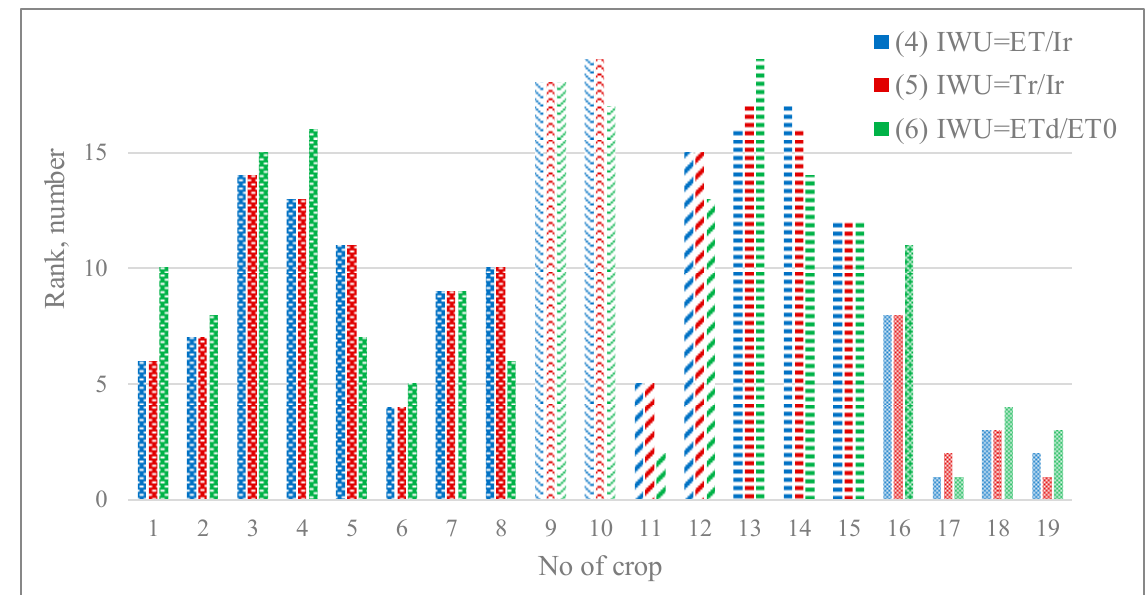
Figure 7. Results of ranking 19 crops of irrigated alfalfa in terms of water efficiency (4)–(6).